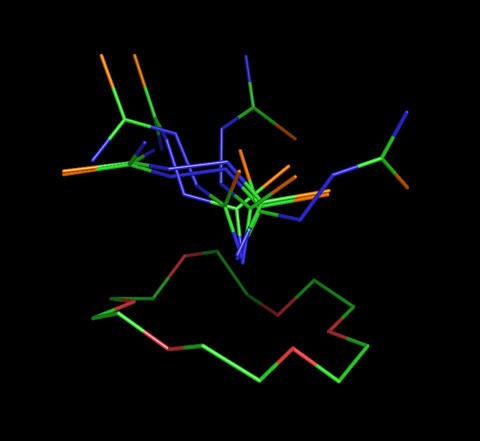
Six energetically indistinguishable dithiobiurea–18-crown-6 complexes generated by the EUDOC program using local minimum conformations of dithiobiurea.The carbon, nitrogen, and sulfur atoms are green, blue, and orange, respectively.